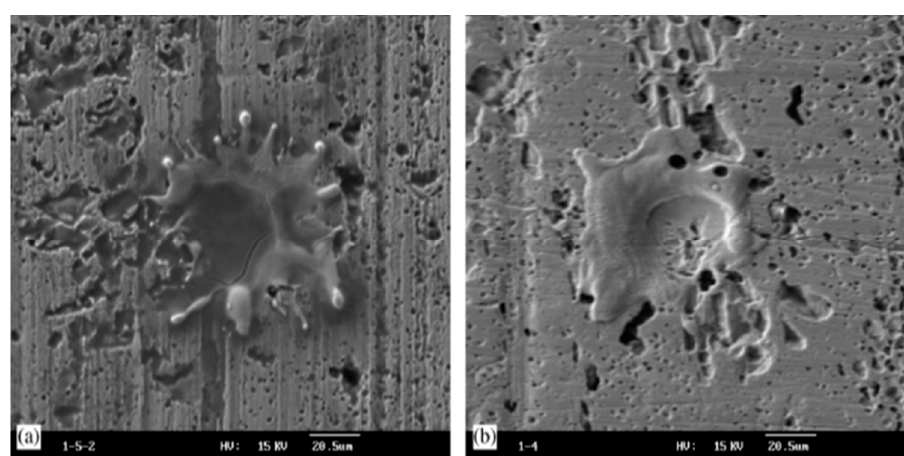
Figure 5. SEM microphotographs of single craters under different pulse durations [202].